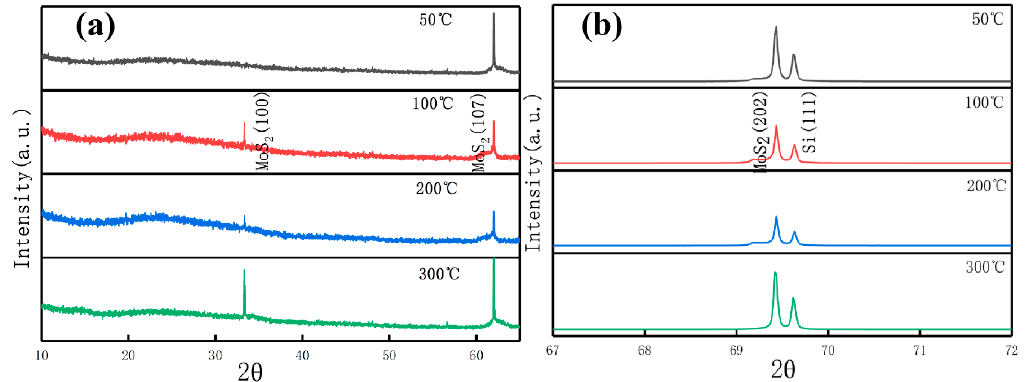
Figure 4. X-ray diffraction (XRD) patterns of the MoS 2 films prepared at different deposition temperatures. Different diffraction angle range: ( a ) 2 θ = 10°~65°, ( b ) 2 θ = 67°~72°. (Picture a and b are continuous, and picture a is magnified)